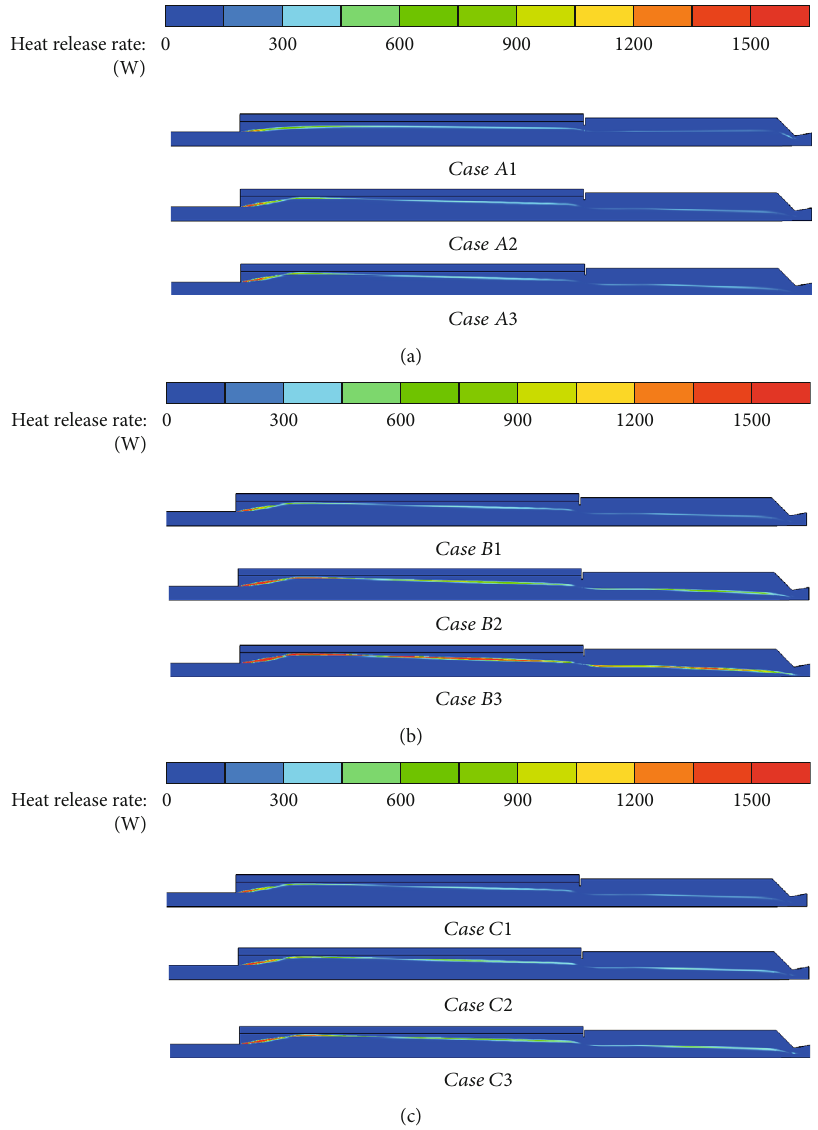
Figure 20: Contours of the heat release rate for the cases with di ff erent inlet